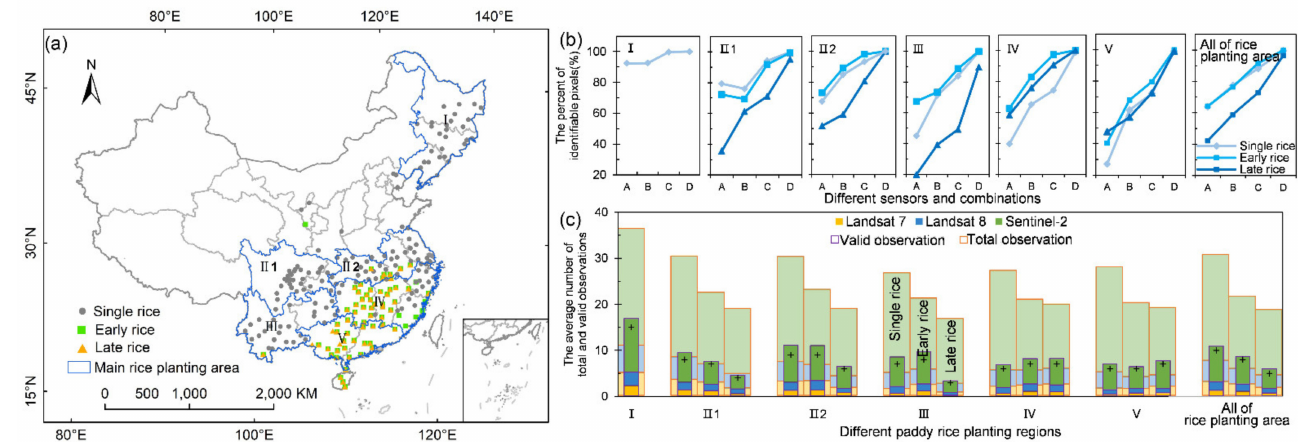
Figure 4. Observation availability of the six main rice cultivation areas in China. ( a ) The main rice cultivation areas with in situ phenology observation sites: I, single rice in northeast China; II1, single rice in the Sichuan Basin; II2, single rice in the mid-lower Yangtze River Valley; III, single rice in the Yunnan–Guizhou Plateau; IV, double rice in the mid-Yangtze River Valley; V, double rice in southern China. ( b ) The percentages of identifiable rice paddy pixels with different sensors and combinations in each main rice cultivation area in China. A, B, C, and D at the x axis represent Landsat-7, Landsat-8, Landsat-7 and 8, and Landsat-7 and 8 with Sentinel-2, respectively. ( c ) The average number of total and valid observations during the flooding and rice transplanting period of single rice (the first bar), early rice (the second bar), and late rice (the third bar) for various sensors. The plus sign represents the median of valid observations of all pixels under the combination of all three sensors in each